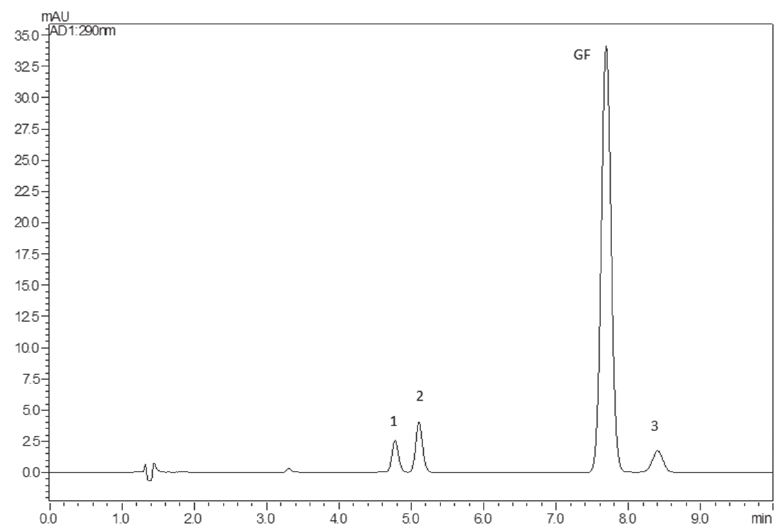
FIGURE 8 - GF and impurity chromatogram in the presence of P407 - 1: griseofulvinic acid; 2: dechlorogriseofulvin; GF: griseofulvin; and 3: